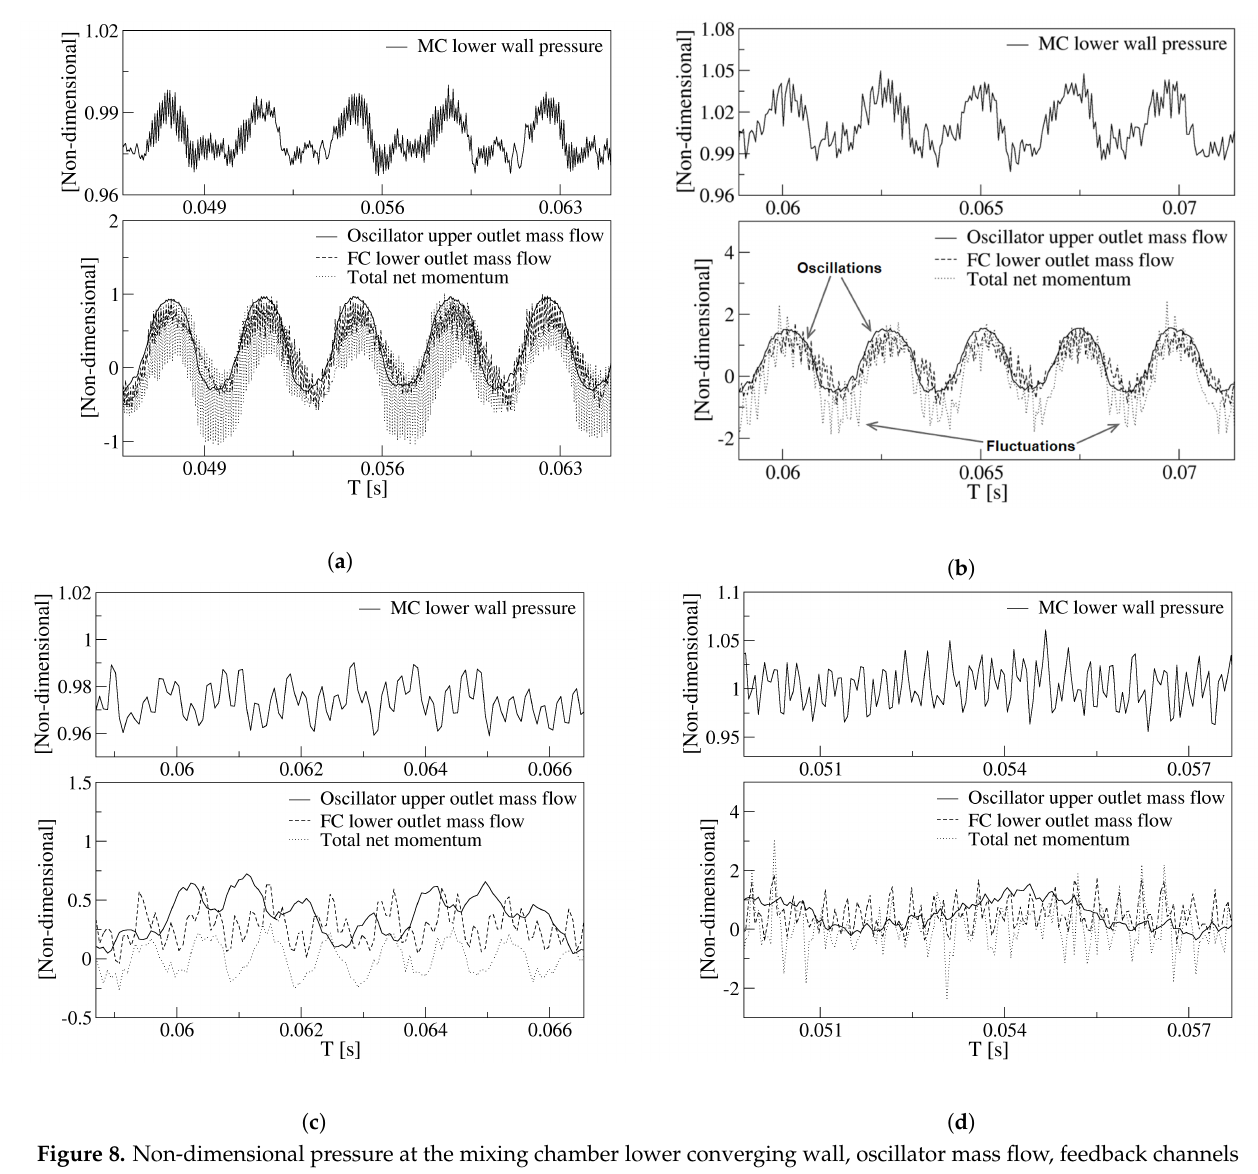
Figure 8. Non-dimensional pressure at the mixing chamber lower converging wall, oscillator mass flow, feedback channels mass flow and total net momentum applied to the incoming jet from both feedback channel outlets. ( a , b ) Baseline case. ( c , d ) Feedback channels length, 9L. ( a , c ) Power nozzle velocity, 65 m/s. ( b , d ) Power nozzle velocity, 97